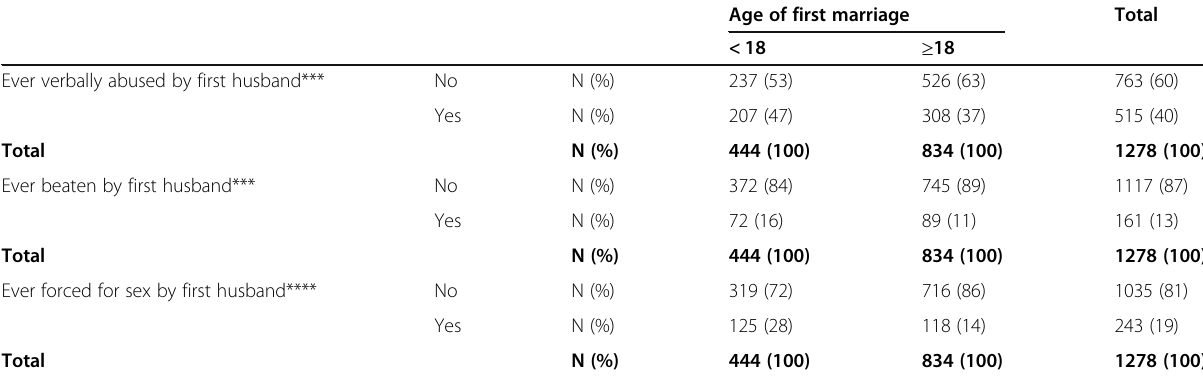
Table 2 Dimensions of abuse by first husband by age at first marriage